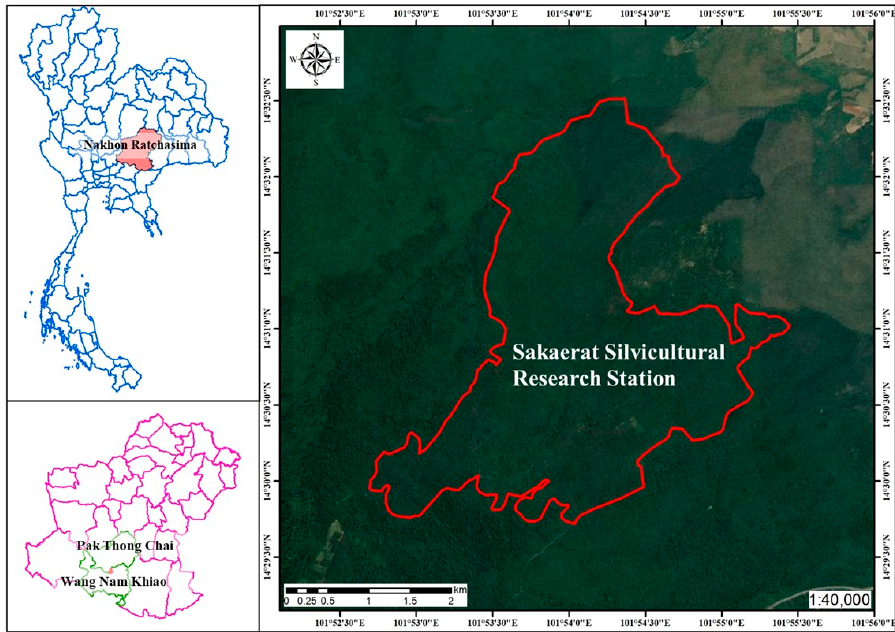
Figure 1. A map of the study site at the Sakaerat Silvicultural Research Station, northeastern Thailand (14 ° 29 ′ 60 ′′ N, 101 ° 54 ′ 19 ′′ E).